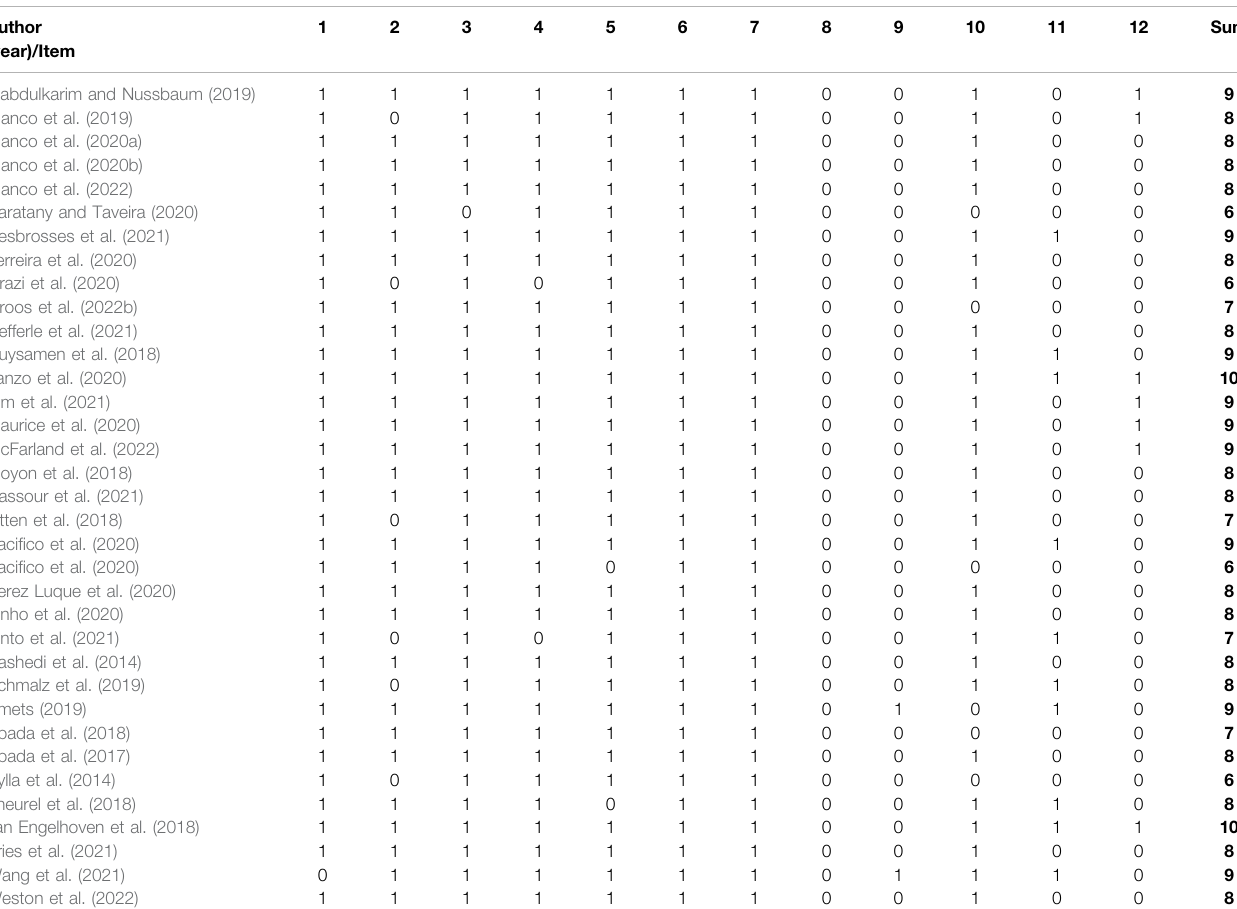
TABLE 2 | Results of the quality assessment. The reader is referred to National Heart, Lung and Blood Institute (2021) for further details on the different items of the quality assessment tool. Author